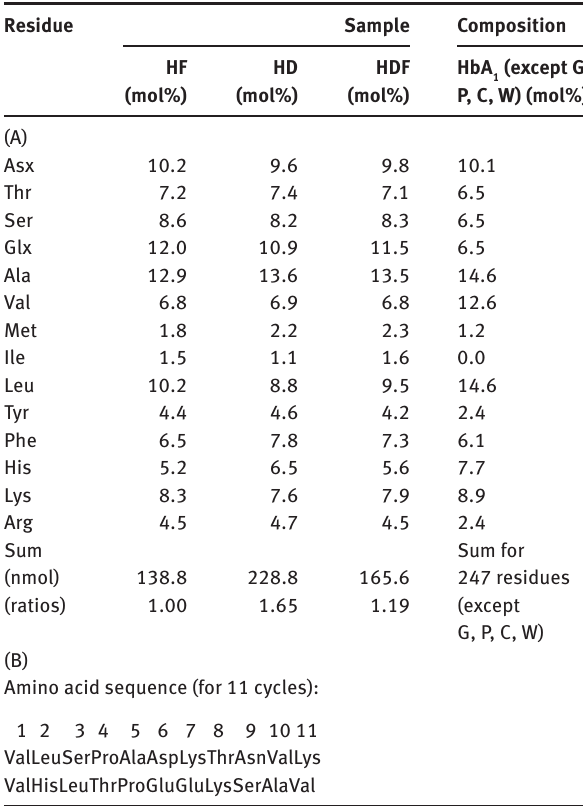
Table 1: Amino acid compositions (A) and N-terminal sequences (B) of the extracted material from the used membranes in each of the three modalities (HF, HD,